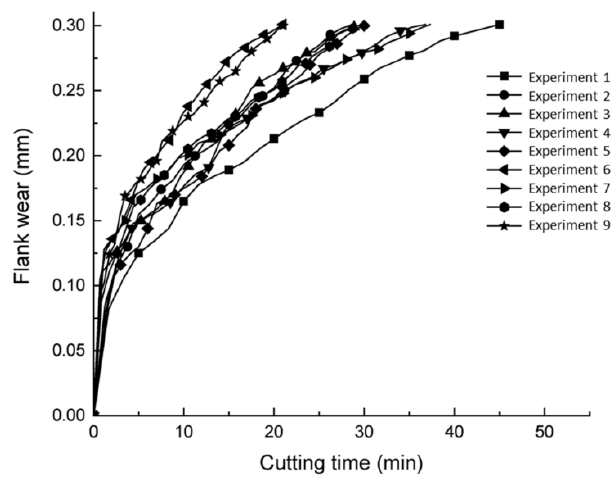
Figure 2. Flank wear vs. cutting time under cryogenic cooling conditions.